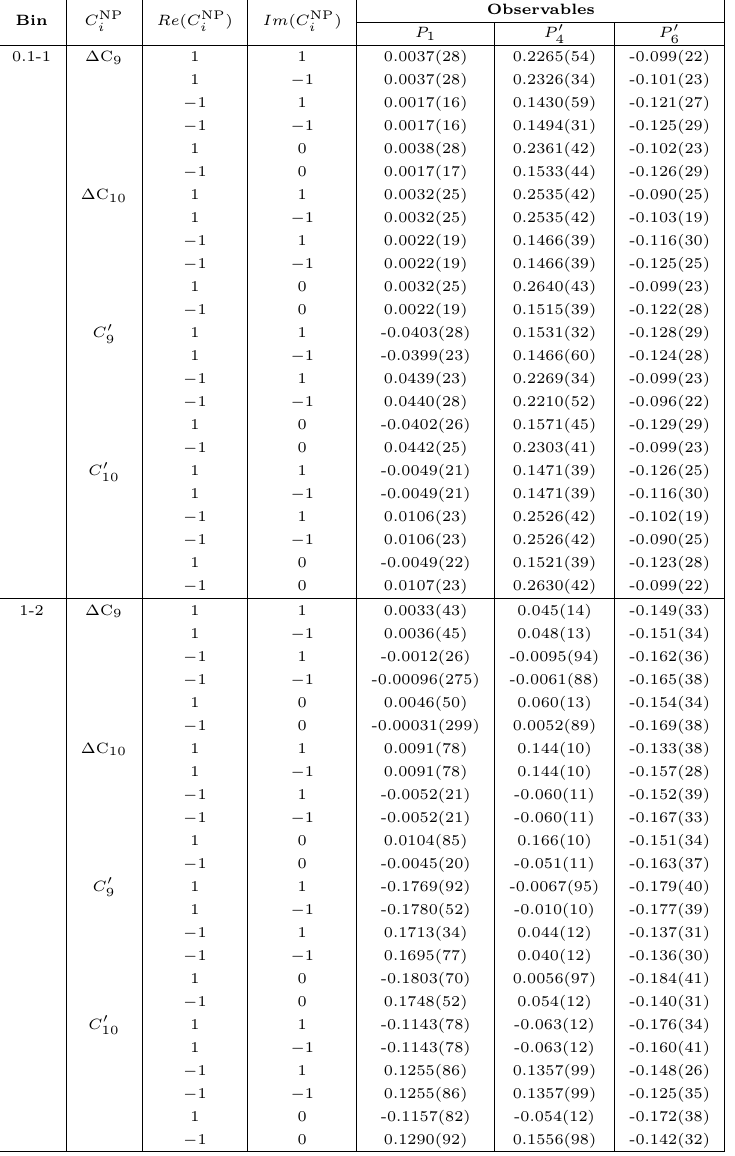
Table 36 . The dependence of the optimized observables corresponding to and imaginary parts of the NP WC’s ∆ C few benchmark values of the real and imaginary parts of the corresponding